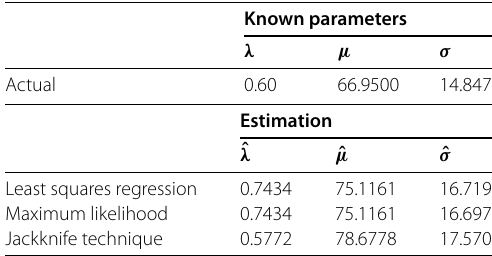
Table 3 Parameter estimation for RSS3